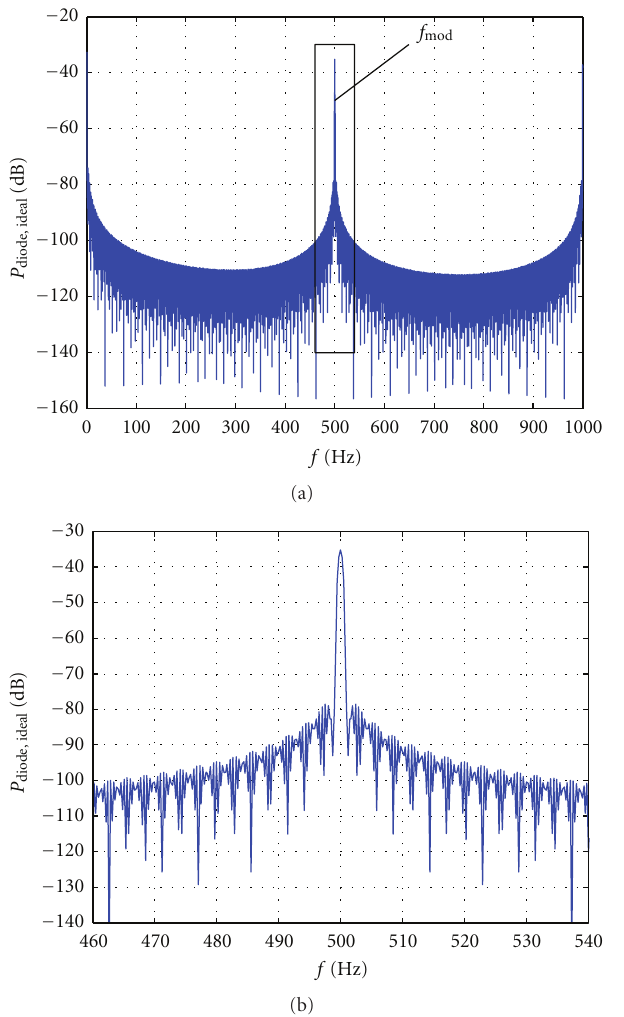
Figure 7: PSD of the ideal photodiode current signal. (a) depicts the entire spectrum, whereas (b) shows a detailed view of the power spectral density around the modulation frequency f mod .